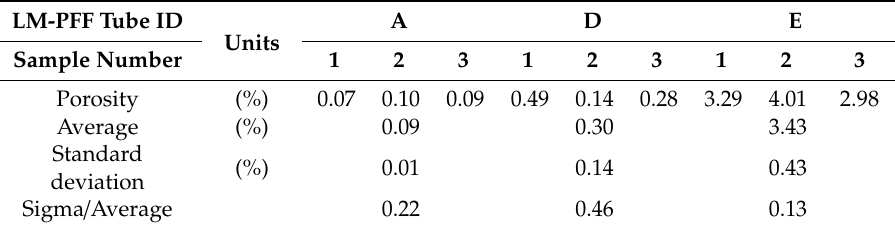
Table 3. Inductively coupled plasma and optical emission spectrometry (ICP-OES) performed by (Element Materials Technology, Rotherham, UK) was used to confirm the chemical composition of the alloy produced by the LM-PBF. The nominal dimensions of the extruded IN718 tube was (mm) 50 outer diameter, 2 wall thickness, and 55 height, with a macro hardness 64